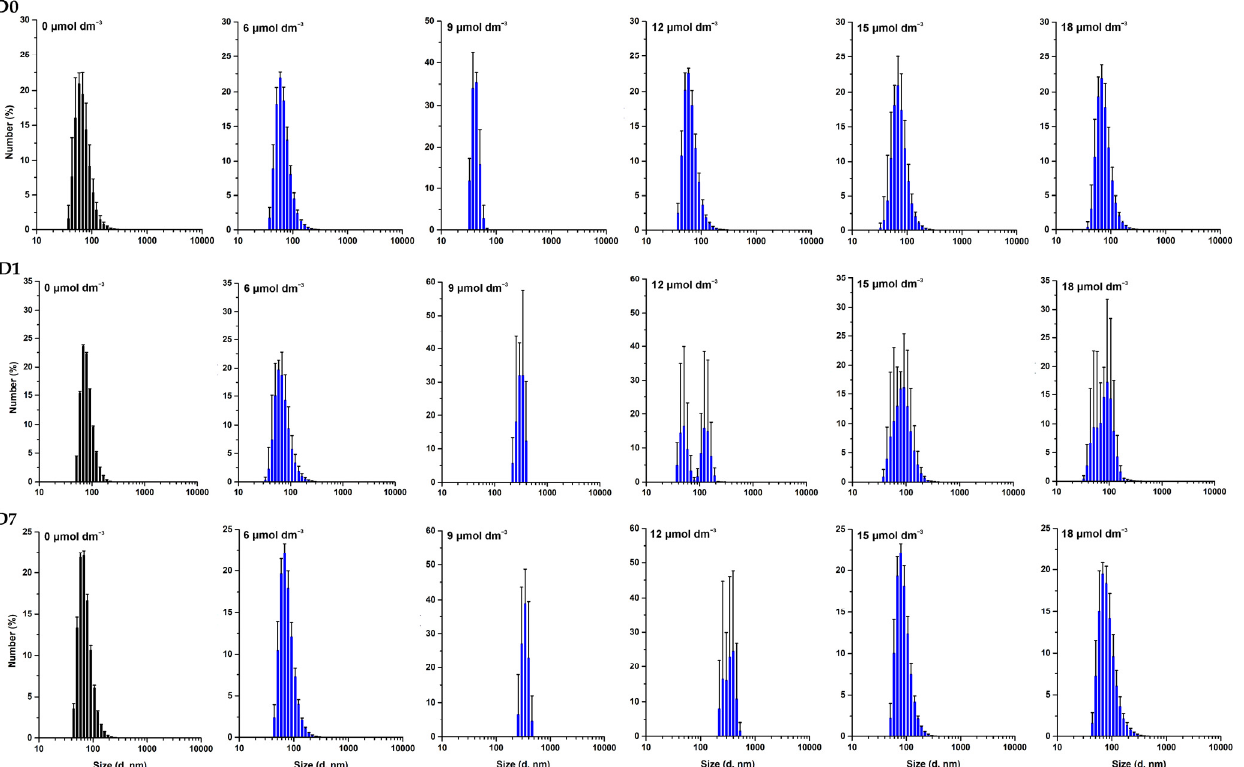
Figure 3. Size distribution of POPC:POPG (1:1) LUVs in the presence of W-BP100 obtained by DLS. Number-weighted size distribution of 100 µmol dm − 3 POPC:POPG (1:1) LUVs in the absence (black) and presence (blue) of increasing W-BP100 concentrations, at days 0 (10 min upon peptide incubation), 1, and 7 upon peptide incubation, at 25.0 ± 0.1 °C. d stands for vesicle diameter. Data are the mean ± SD of three replicate measurements (one single experiment).